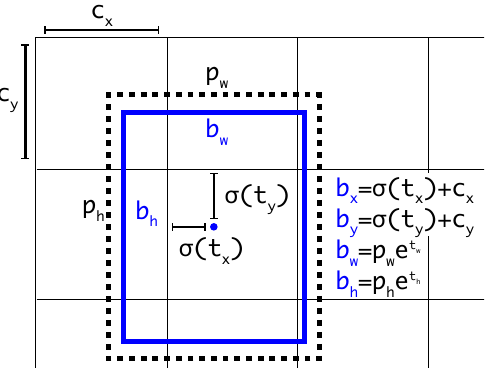
Figure 2. Bounding boxes with dimension priors and location